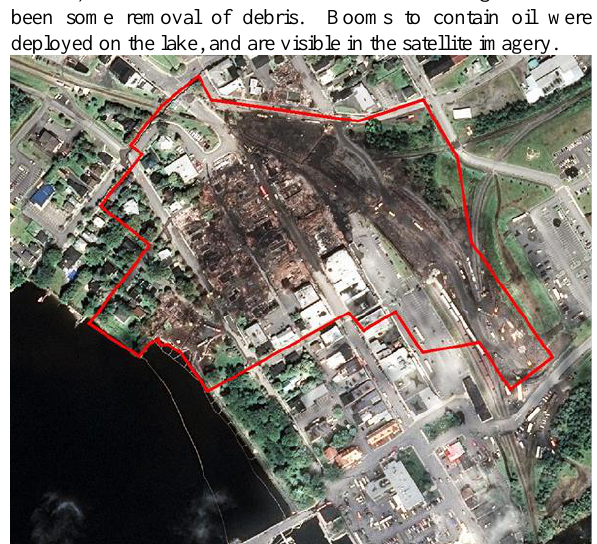
Figure 6. Pléiades image acquired three week post derailment